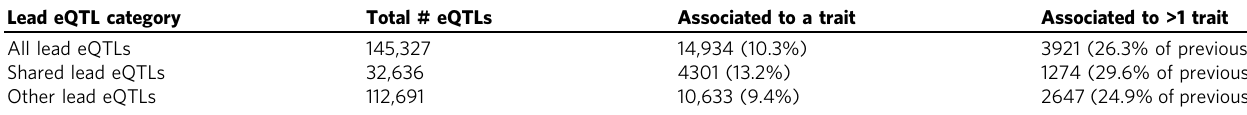
Table 1 Number of lead eQTLs associated with one or more